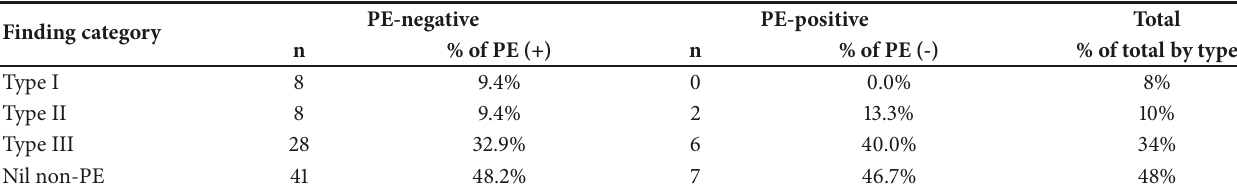
Table 1: Findings of CTPA categorized by PE detection and finding types, represented as proportions of PE-positive or PE-negative findings, respectively. Finding types are also represented as a proportion of all findings, independent of PE detection on the right side.